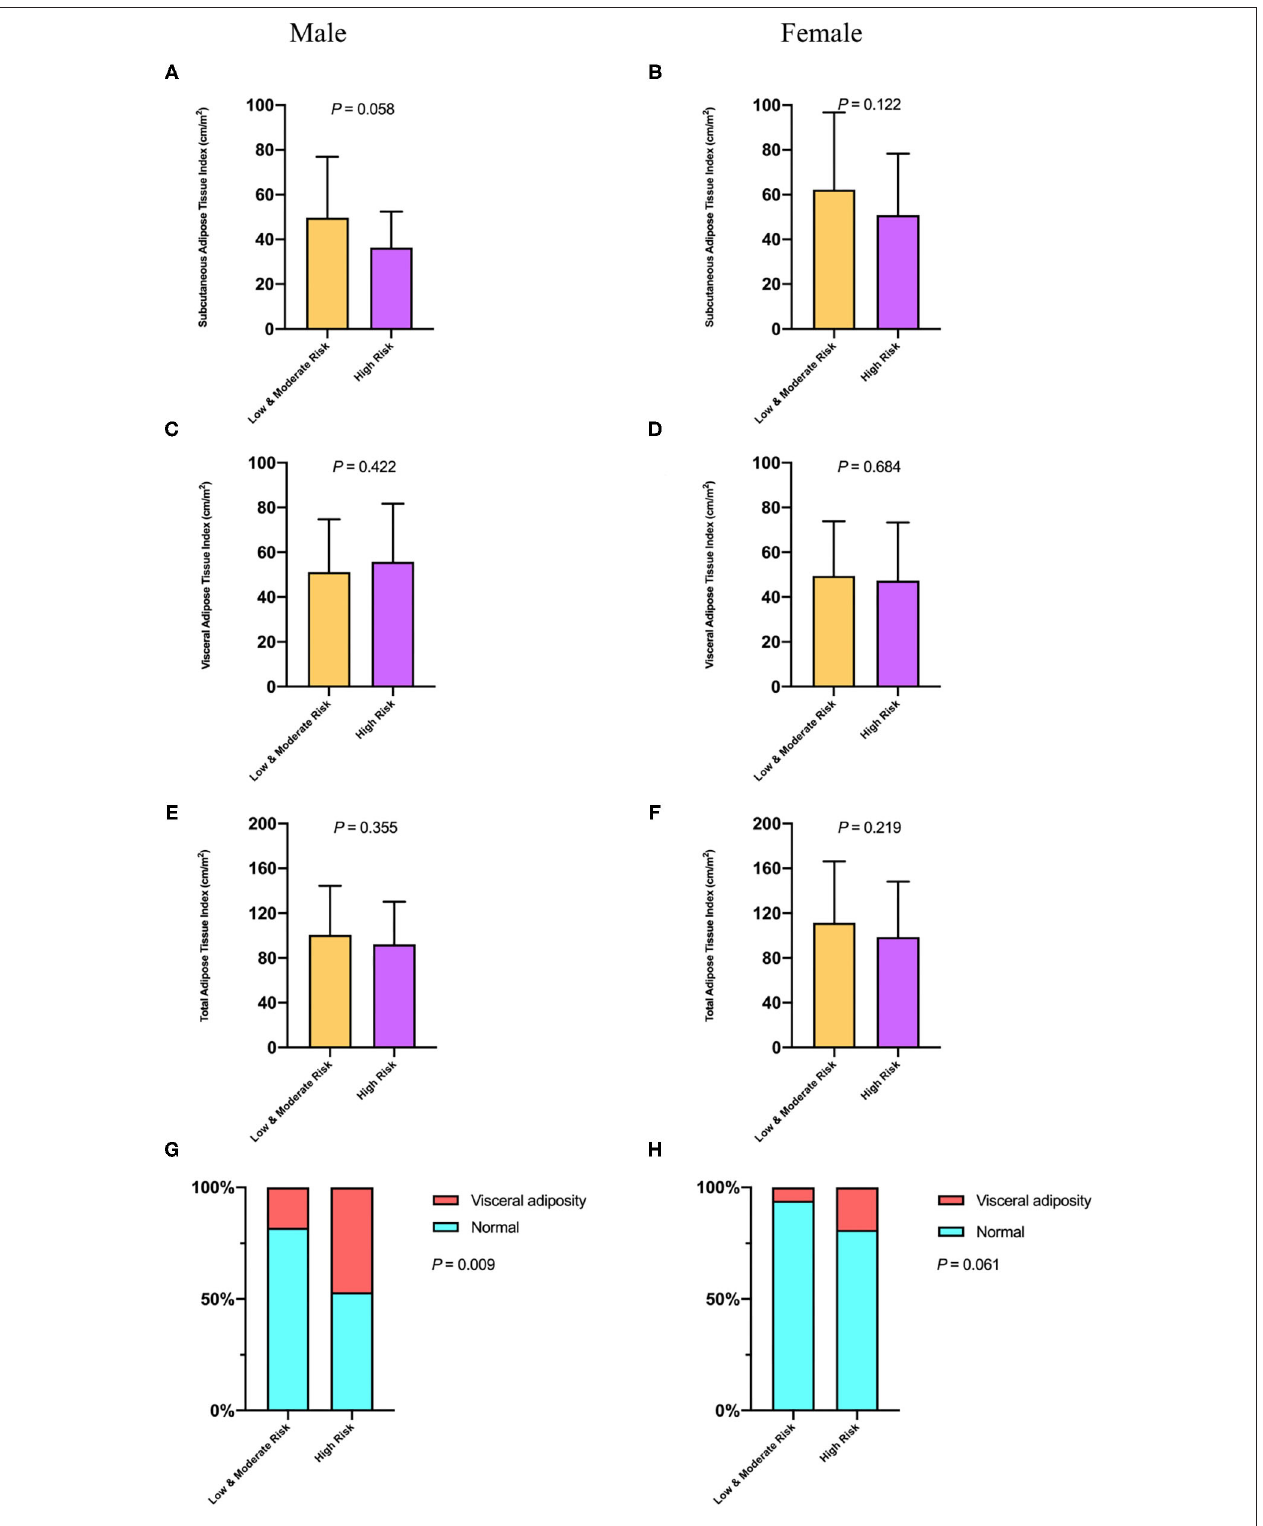
FIGURE 2 | The comparison of subcutaneous adipose tissue index (A,B) , visceral adipose tissue index (C,D) , total adipose tissue index (E,F) , and visceral adiposity (G,H) in both genders with distinct malnutrition risk of hospitalized patients with cirrhosis.